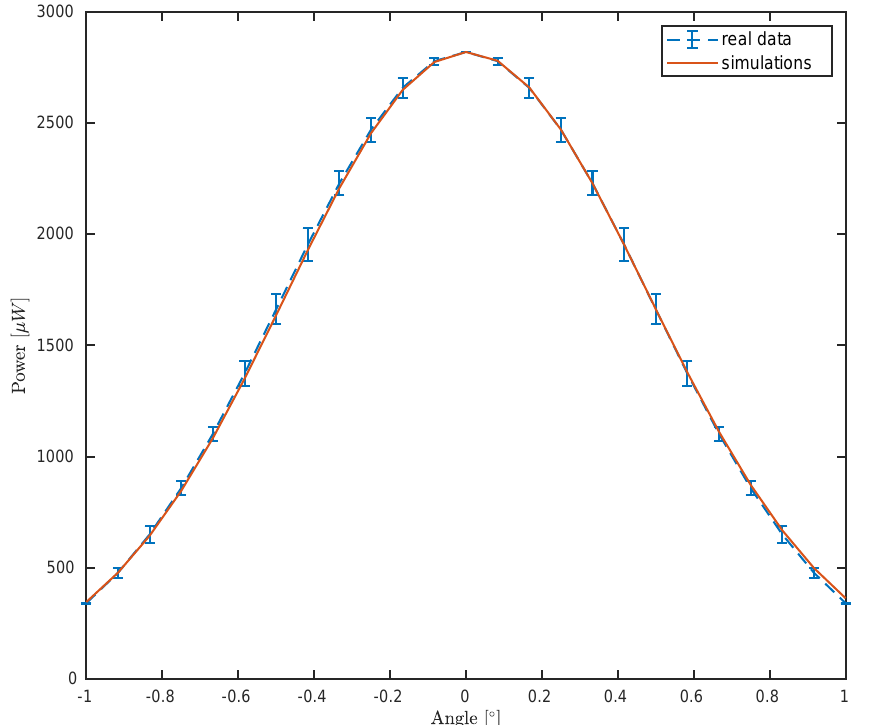
Figure 4. Comparison between the power meter measurements for different angular steps of the mirror (blue dashed curve) as in Section 2.2 and the simulation (red curve) for Equation